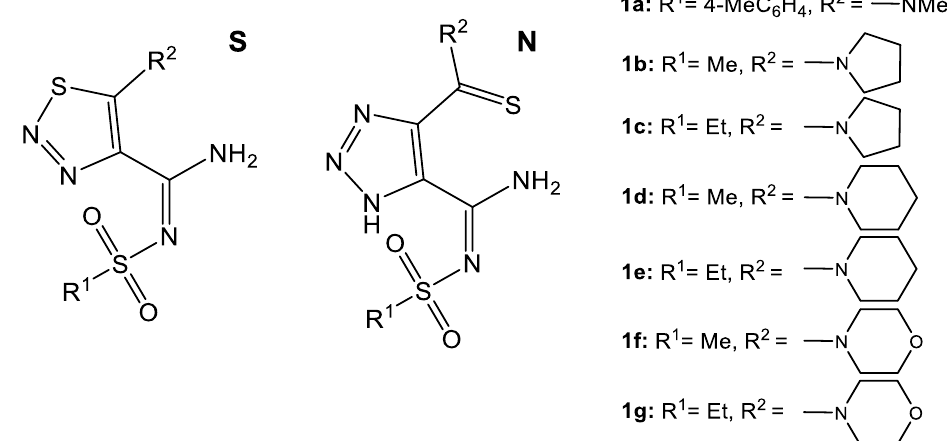
Figure 1. Structures of investigated 4,5-disubstituted 1,2,3-thiadiazoles (S) and 1,2,3-triazoles (N).